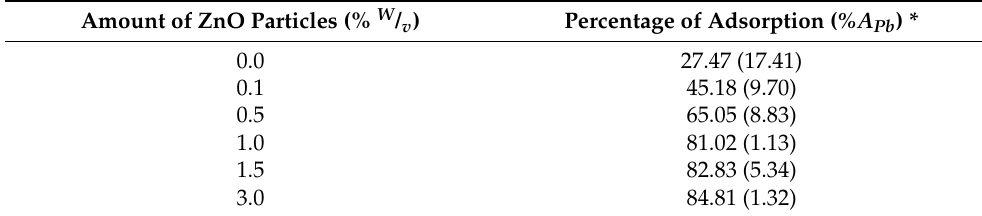
Table 1. Effect of amount of ZnO nanoparticles in the polymeric solution. Amount of ZnO Particles (% W / v )